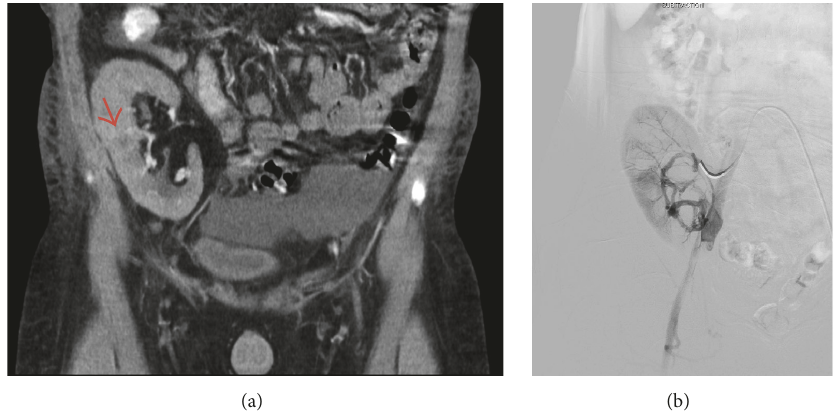
Figure 1: (a) Computed tomography scan coronal section demonstrates an enhancing, round lesion, suspicious for malignancy in the mid renal zone (arrow). (b) Embolization of the renal artery of the renal allograft was performed before graft nephrectomy.